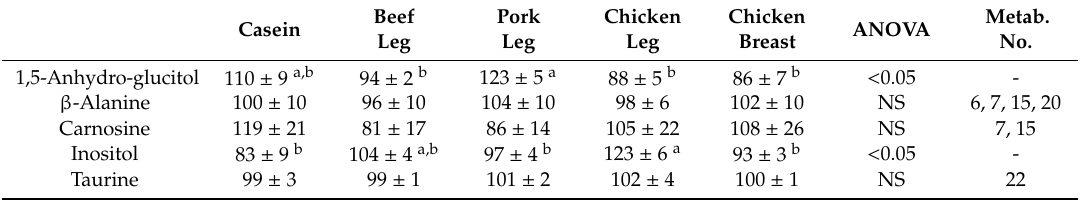
Table 3. E ff ect of dietary protein sources on metabolite levels in the gastrocnemius muscle of